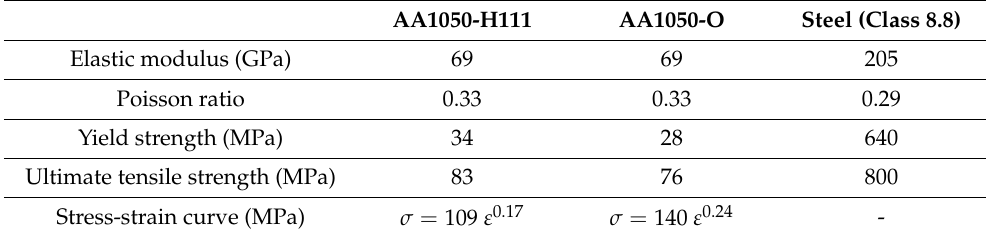
Table 2. Mechanical properties of the materials.